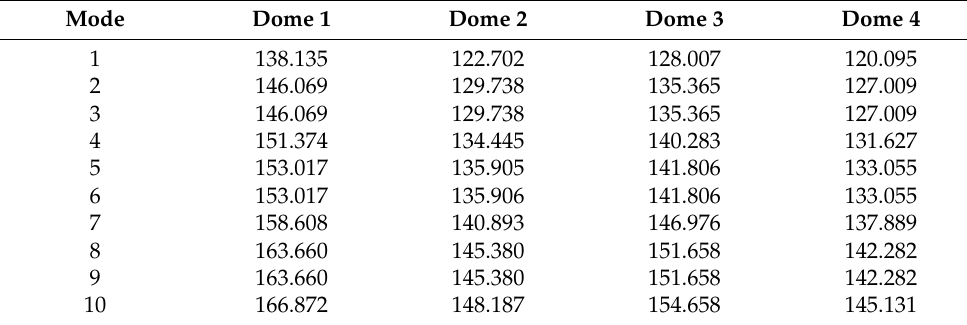
Table 2. Natural frequencies of domes with different cross-sections